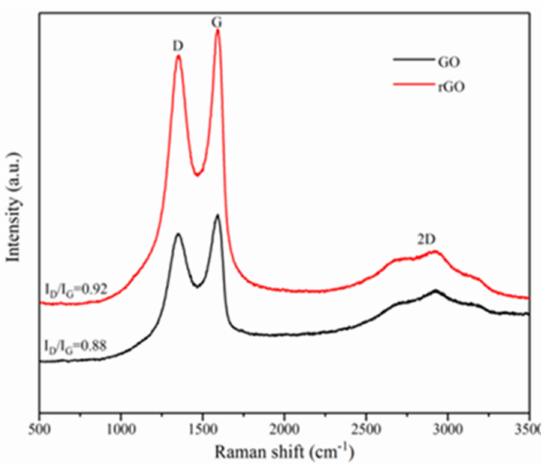
Figure 6. Test model of the samples for dielectric behaviors and electrical conductivity.